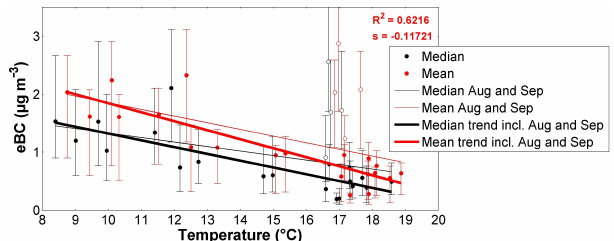
Figure 11. Monthly median and mean eBC (with bars indicating 25th and 75th percentiles) plotted against monthly median and mean temperatures for